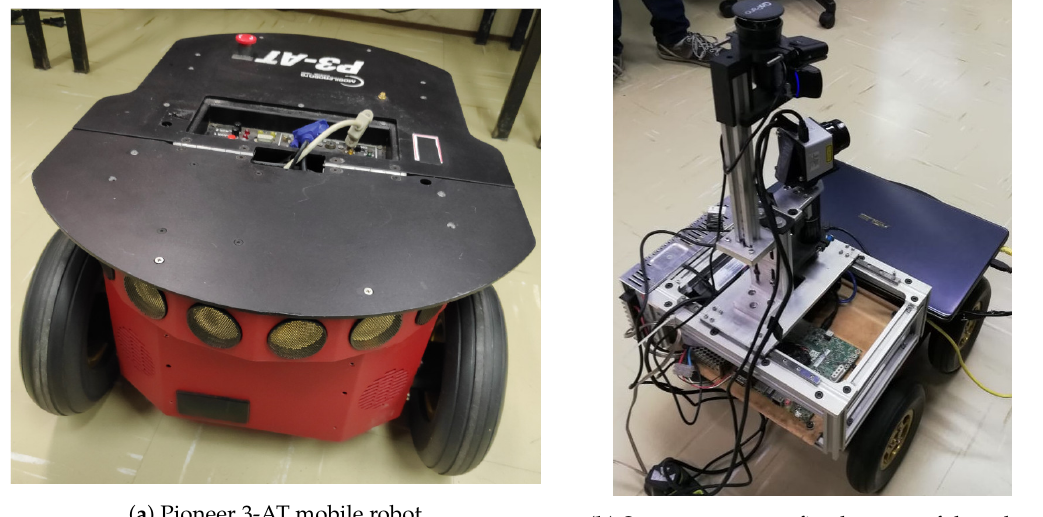
Figure 11. Experimentation